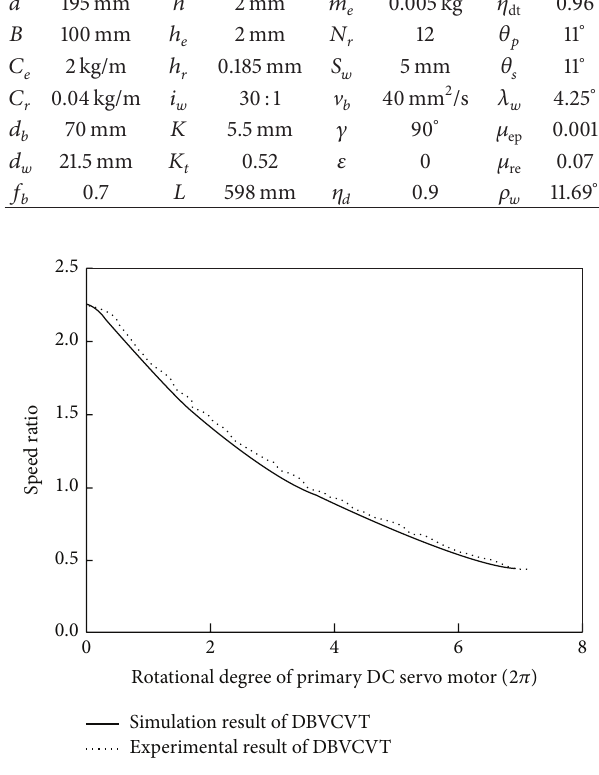
Figure 6: Relationship between speed ratio and rotational degree of primary DC servo